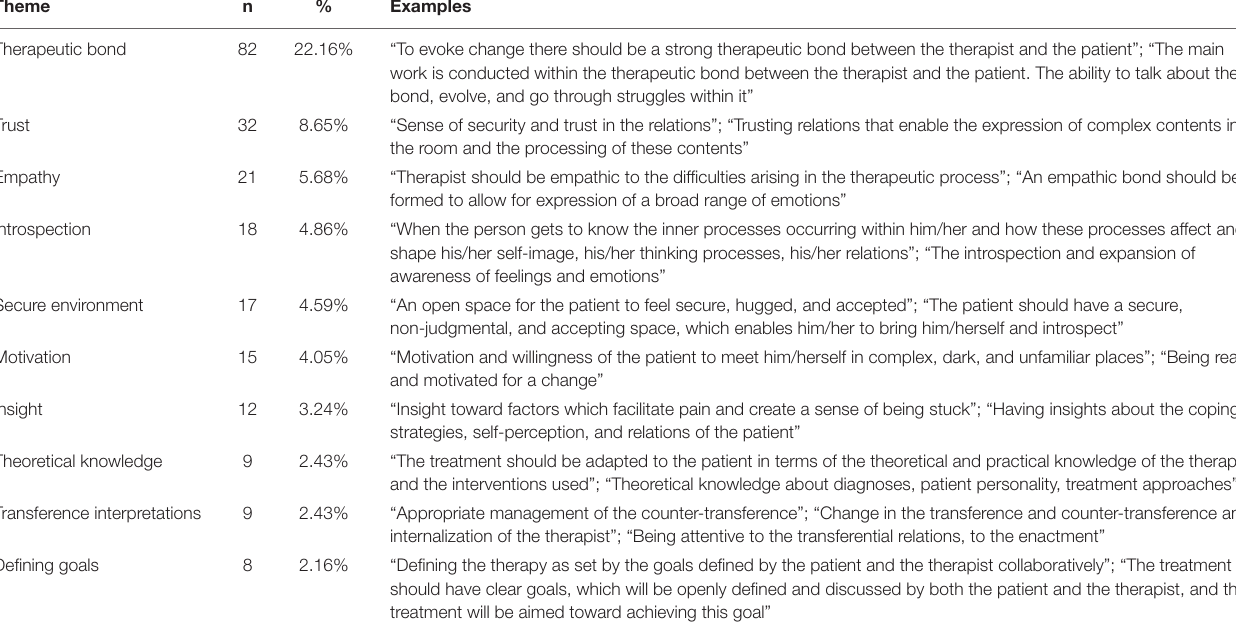
TABLE 2 | List of the 10 most expressed themes by therapists as the mechanisms of change in psychotherapy, number of responses, and percentages of the overall number of responses. Theme n %